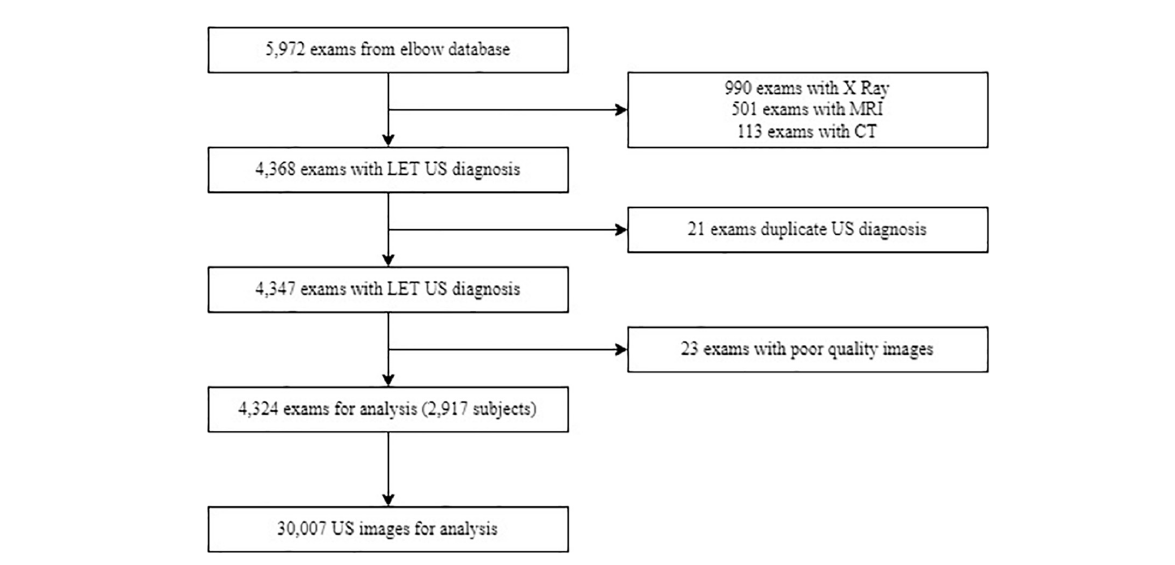
FIGURE1 Flowchart of data selection and subjects used in the study. Abbreviations: MRI, magnetic resonance imaging; CT, computed tomography scan; LET, lateral elbow tendinopathy; US,